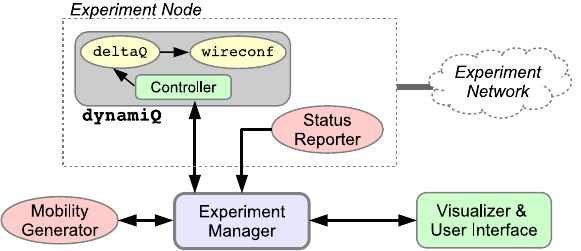
Figure 1: Architecture of the interactive experiment framework.